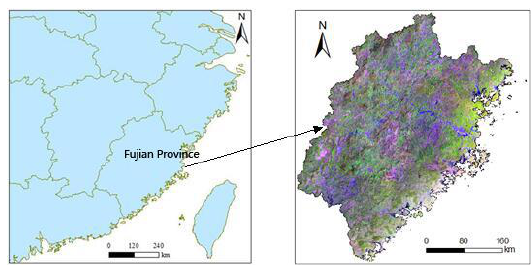
Figure 1. The location of study